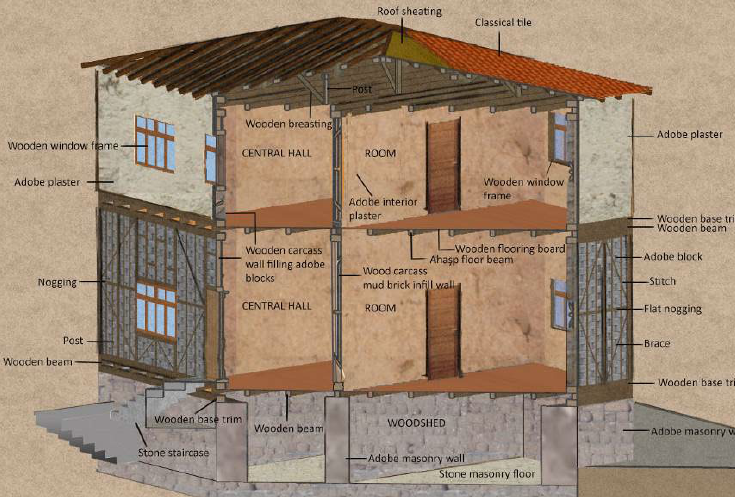
Figure 14 "Hımış" construction technique an d building formation (illustration: authors).